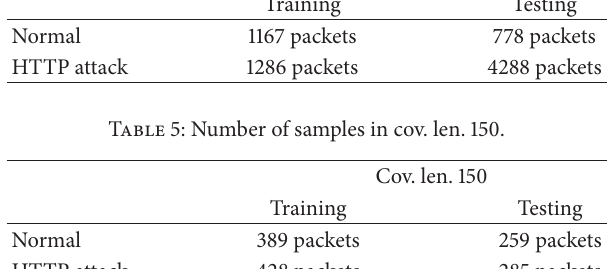
Figure 2: Cloud internal flooding attacks network architecture.